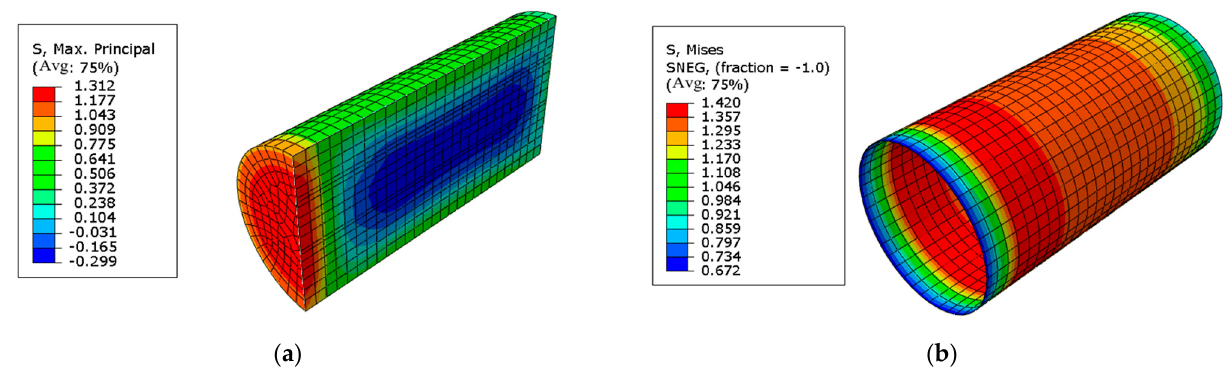
Figure 15. Stress in cylindrical model at 99–100 freeze–thaws. ( a ) Stress of concrete; ( b ) stress of fiber cloth.